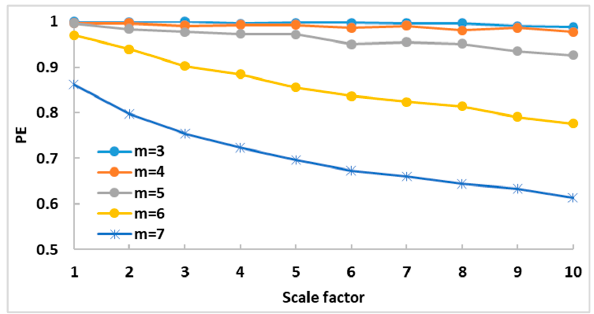
Figure 2. Permutation entropy (PE) of Gaussian white noise in different embedding dimensions.